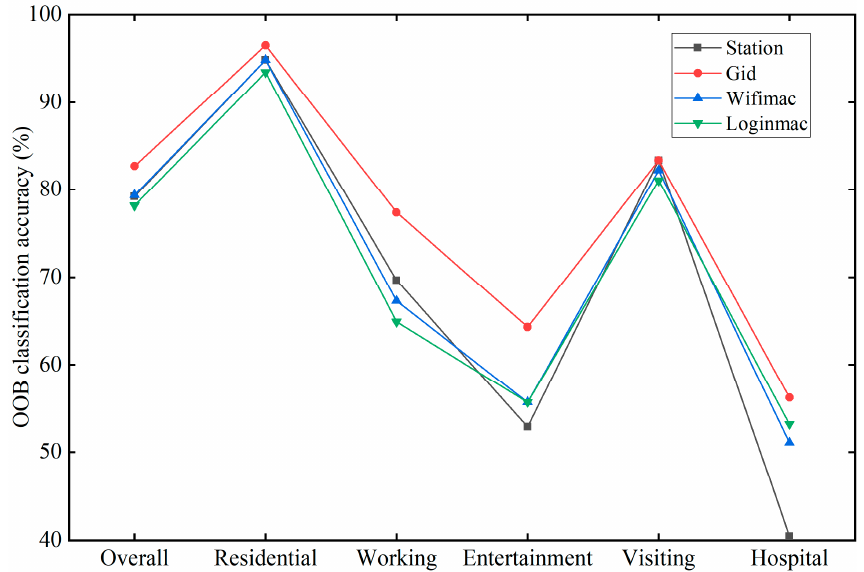
Figure 10. OOB classification accuracy of the five building function types for the four MS indicators.